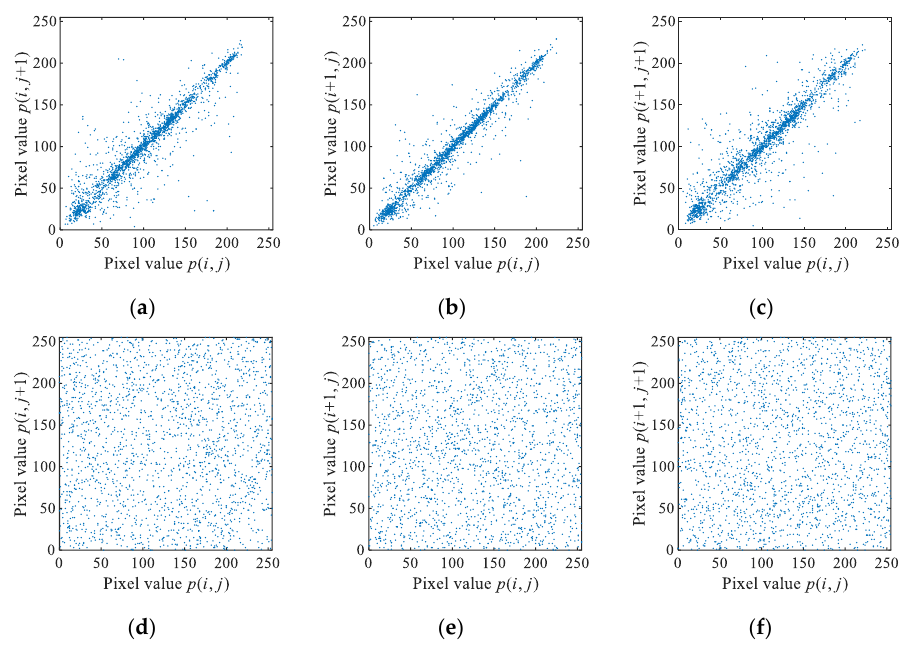
Figure 10. Correlation point diagrams of plaintext image Lena and encrypted image Lena. ( a ) Original Lena in horizontal direction, ( b ) Original Lena in vertical direction, ( c ) Original Lena in diagonal direction, ( d ) Encrypted Lena in horizontal direction, ( e ) Encrypted Lena in vertical direction, ( f ) Encrypted Lena in diagonal direction. Table 5. The 2D correlation coefficients (CC) with a different